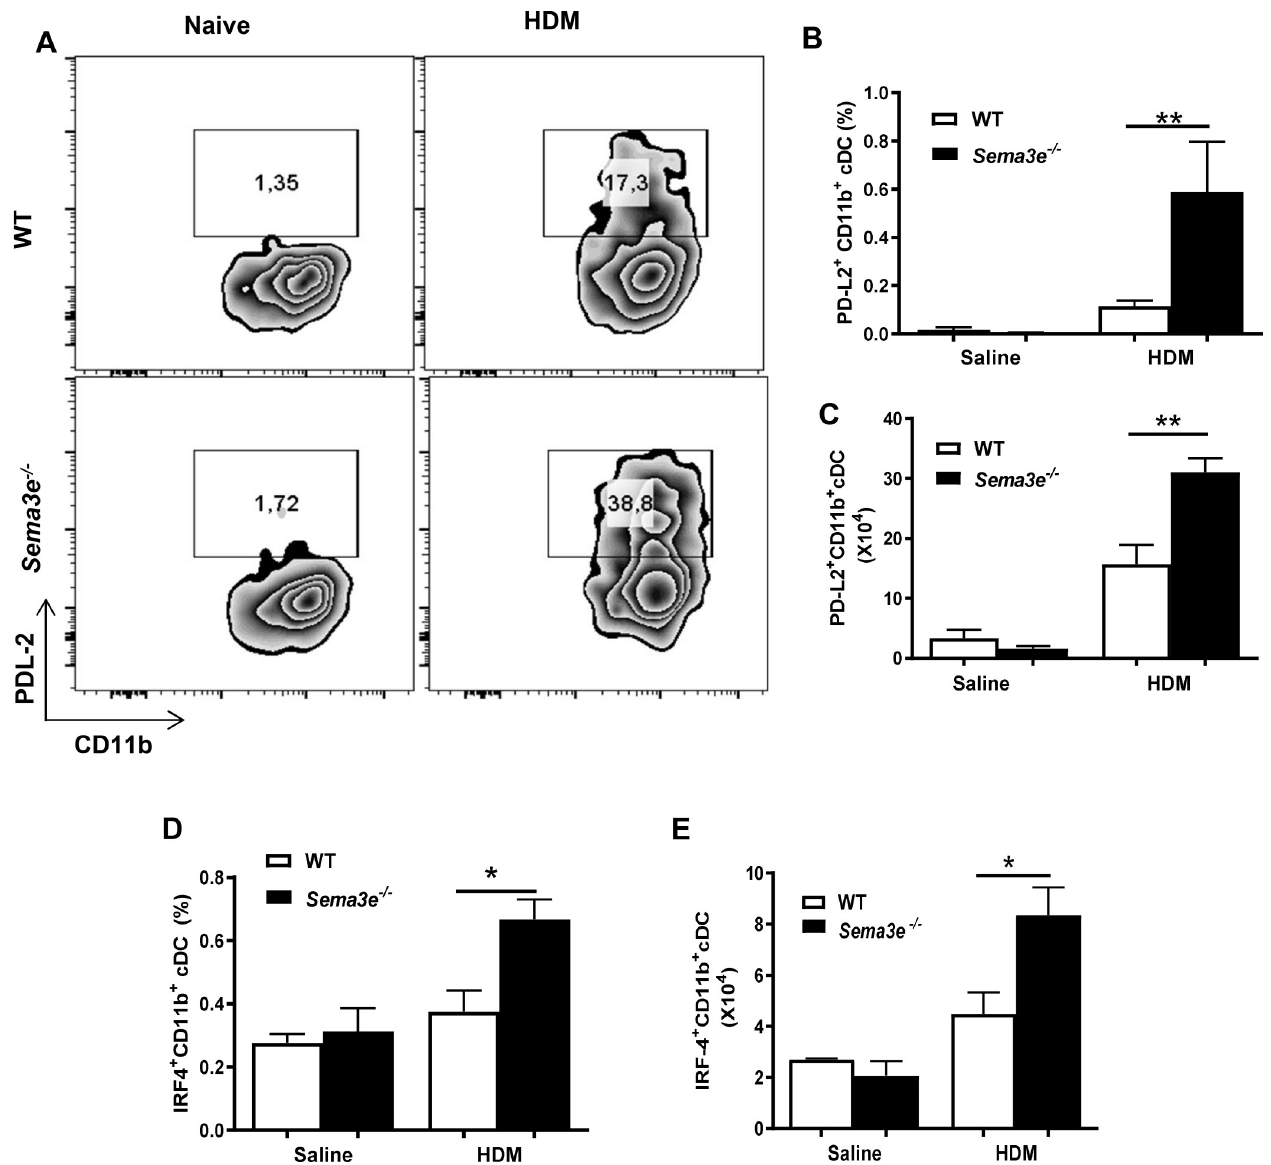
Fig 3. Increased expression of PD-L2 and IF-4 in CD11b + pulmonary cDC in Sema3e -/- mice exposed to HDM. (A-C) Surface expression of PD-L2 was measured on C11b + DC subset from the lungs using flow cytometry. Data represent at least two independent experiments (n = 3–5 mice per group, ��� P < 0.001). (D, E) IRF4 intranuclear protein expression was detected by flow cytometry. Isotype control validates the specificity of staining. Cells were pre- gated as described in Fig 3. Data represent at least two independent experiments, n = 3–5 mice per group. � P < 0 . 05